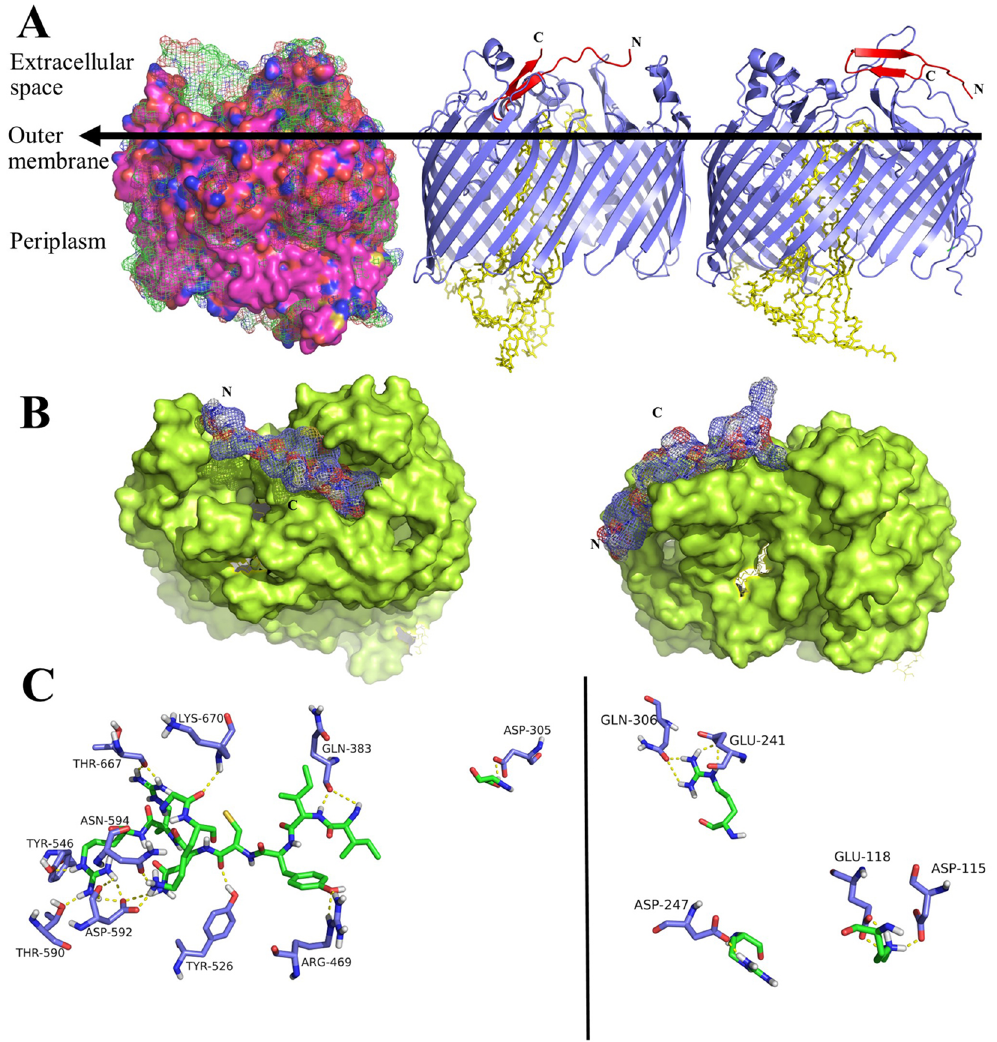
Figure 3. ( A ) Left: the alignment of crystallography structure of Escherichia coli LptD (surface mode, pink and blue) and Pseudomonas aeruginosa (mesh mode, green). Middle: the interaction of thanatin (red) with Escherichia coli LptD (blue)–LptE (yellow) complex. Right: the interaction of thanatin (red) with Pseudomonas aeruginosa LptD (blue)–LptE (yellow) complex. ( B ) Left: the head of outer membrane of Escherichia coli LptD (green) interacted with thanatin. Right: the head of outer membrane of Pseudomonas aeruginosa LptD (green) interacted with thanatin (purple blue). ( C ) (The residues of LptD are not labeled for more clarity) Left: the residue involvement in the interaction of thanatin (green) and Escherichia coli LptD (purple blue). Right: residue involvement in the interaction of thanatin (green) and Pseudomonas aeruginosa LptD (purple